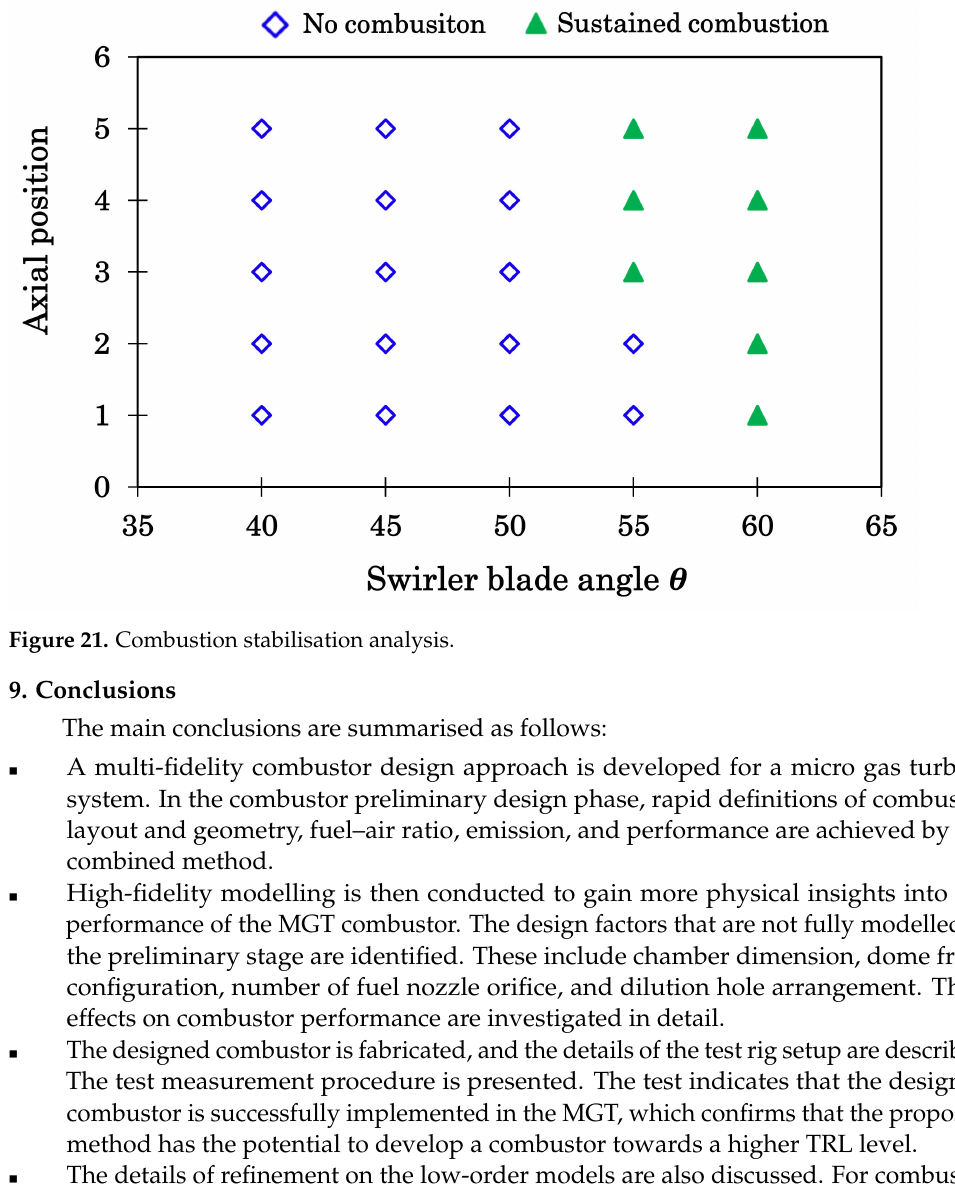
Figure 21. Combustion stabilisation